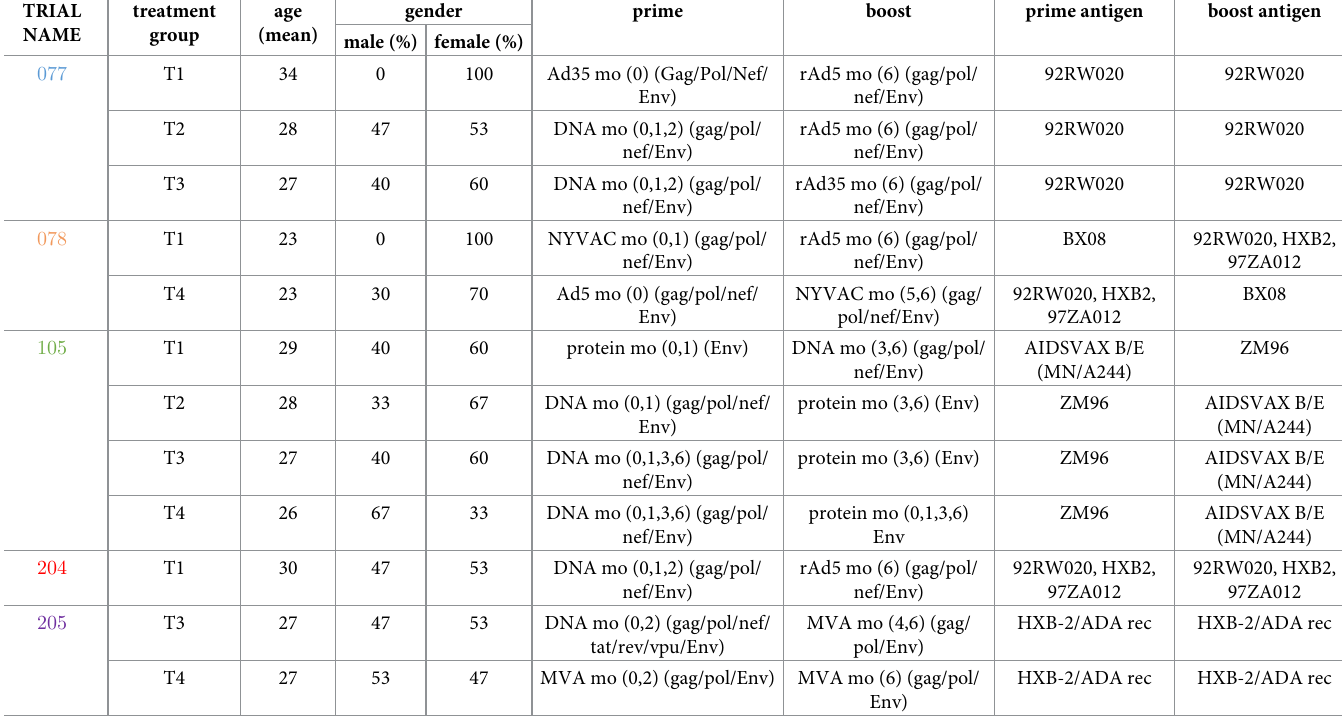
Table 1. Sample selection for HVTN study